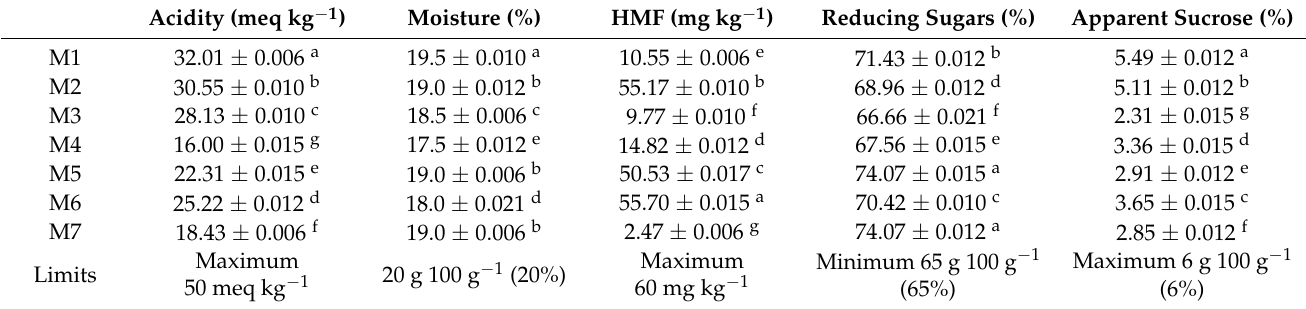
Table 4. Results of analysis and parameter limits for honeys (mean ± SD; n =